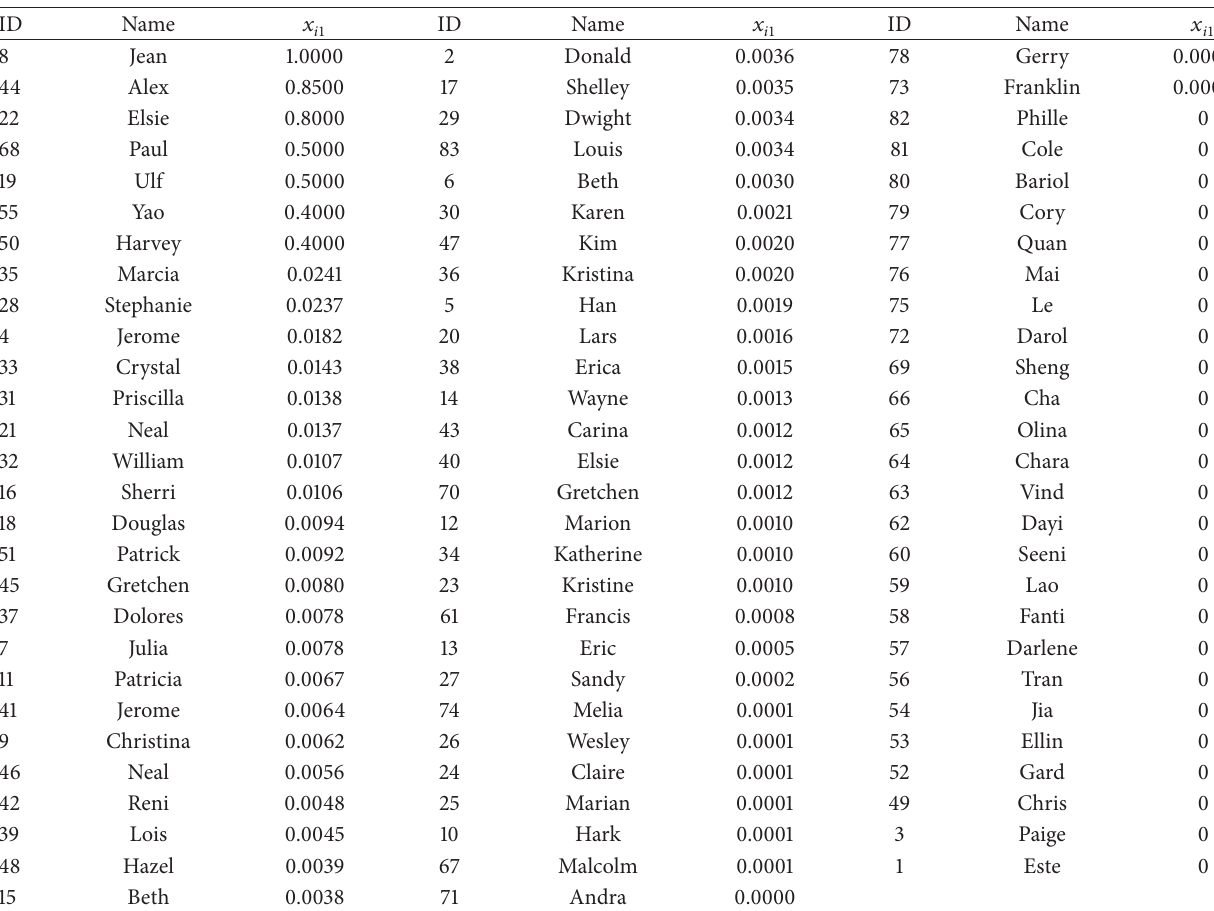
Table 4: Priority list for key